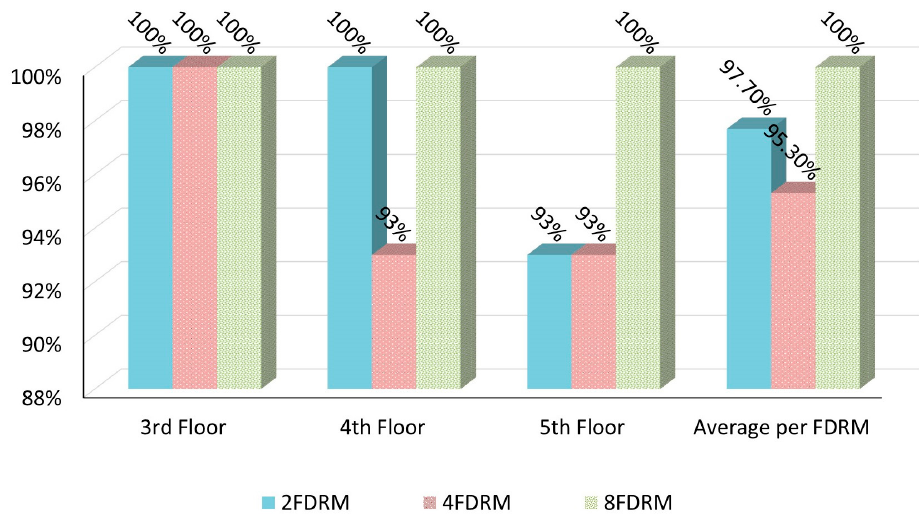
Figure 12. Floor positioning accuracy rate with k = 1.